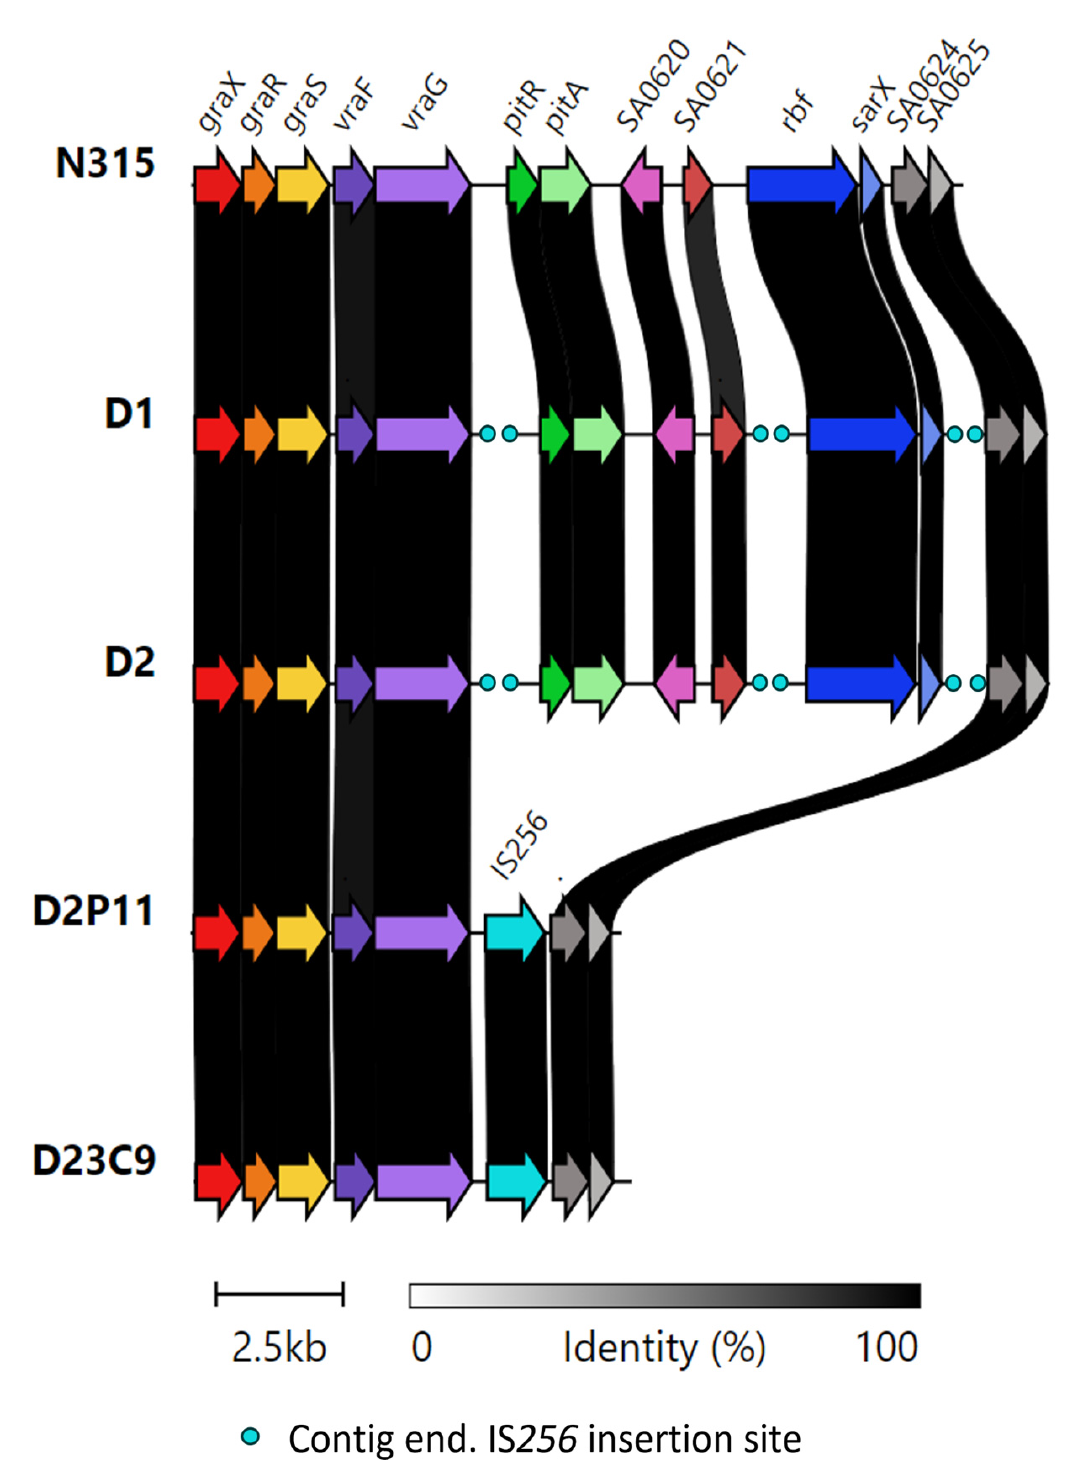
Figure 3. Clinker gene cluster comparison of the genomic region between graX and SA0625. Homologous CDSs are in the same color and linked through grey bars with the percentage amino acid identity, as indicated in the legend. IS 256 insertions are marked as aqua circles (in case of contig ends), or annotated CDS (confirmed by PCR).